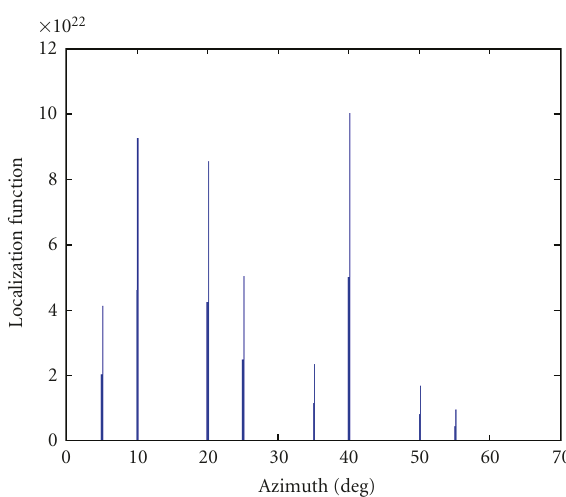
Figure 1: Π Γ -propagator with SNR = 0 dB.